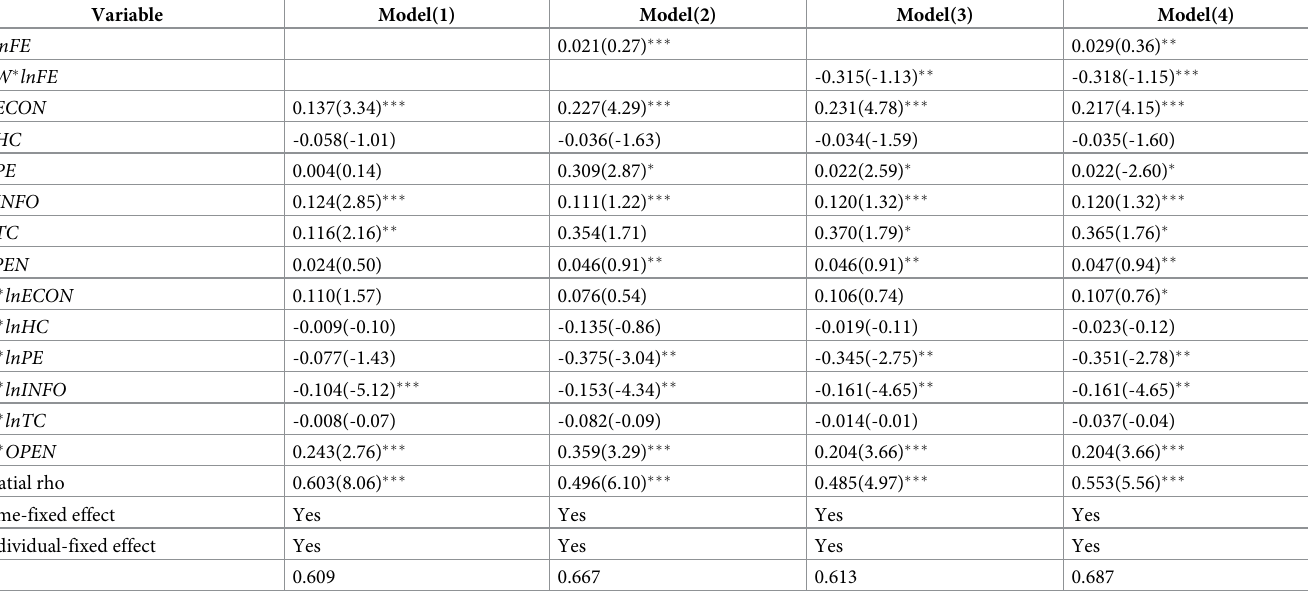
Table 5. Regression results of SDM and DSDM